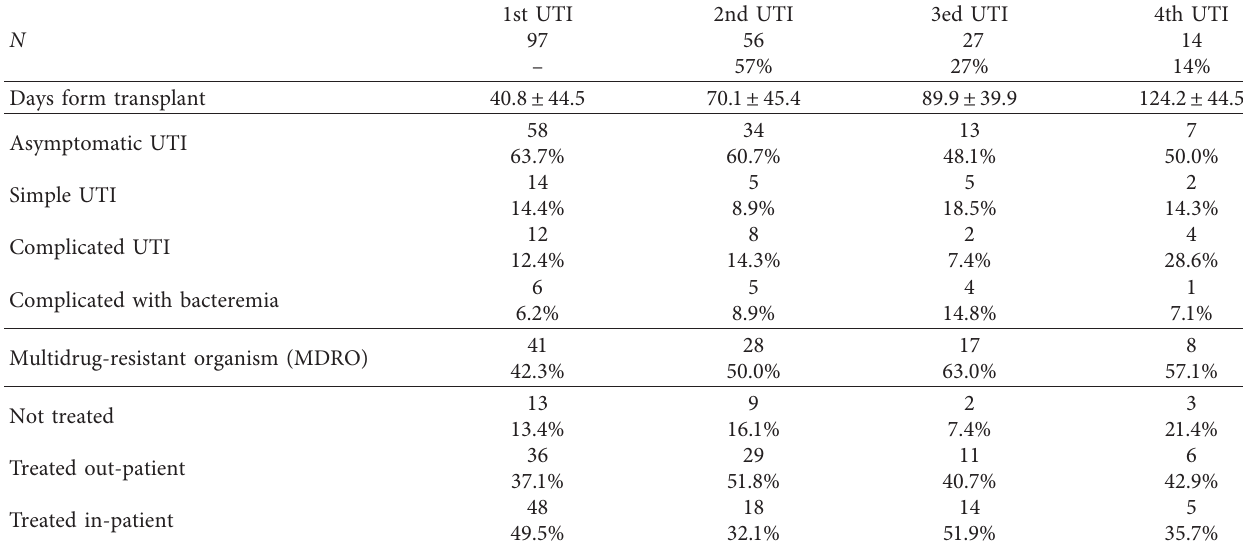
Table 2: Timing and symptomatology and treatment of recurrent UTI after renal